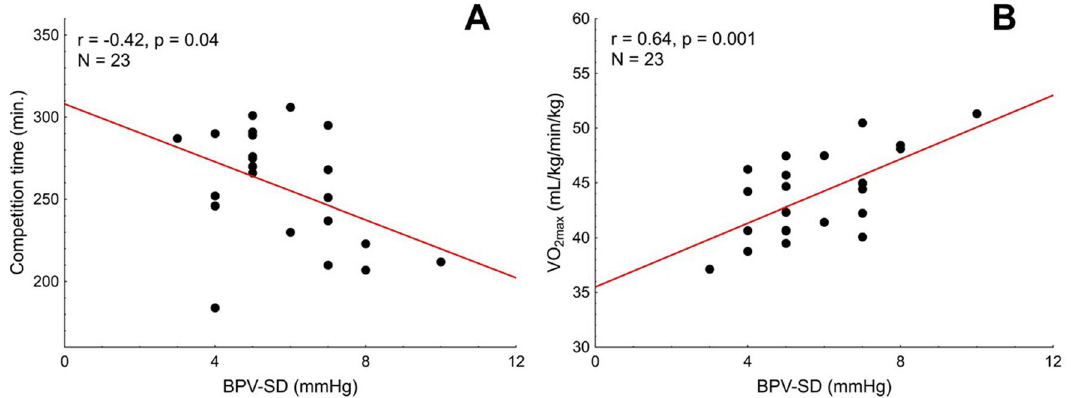
Figure 6. VO 2max ( A ) and the competition time ( B ) plotted against the pre-race standard deviation of the beat- to-beat systolic blood pressure